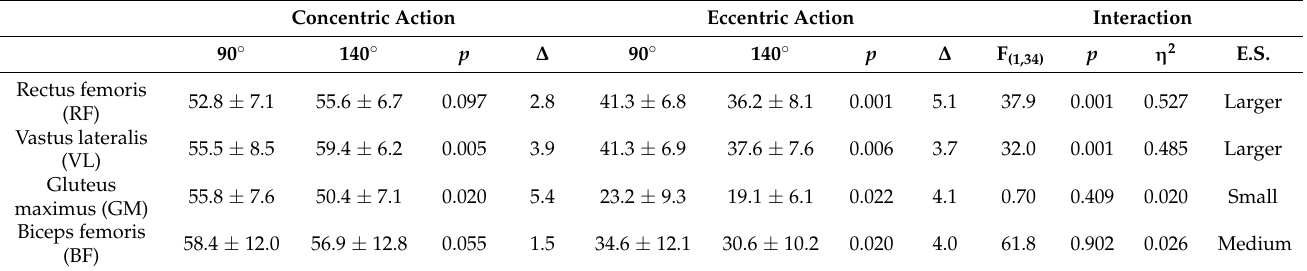
Table 1. Muscular activation and effect size in squat performed by women at 90 ◦ and 140 ◦ of range of motion ( n = 35).